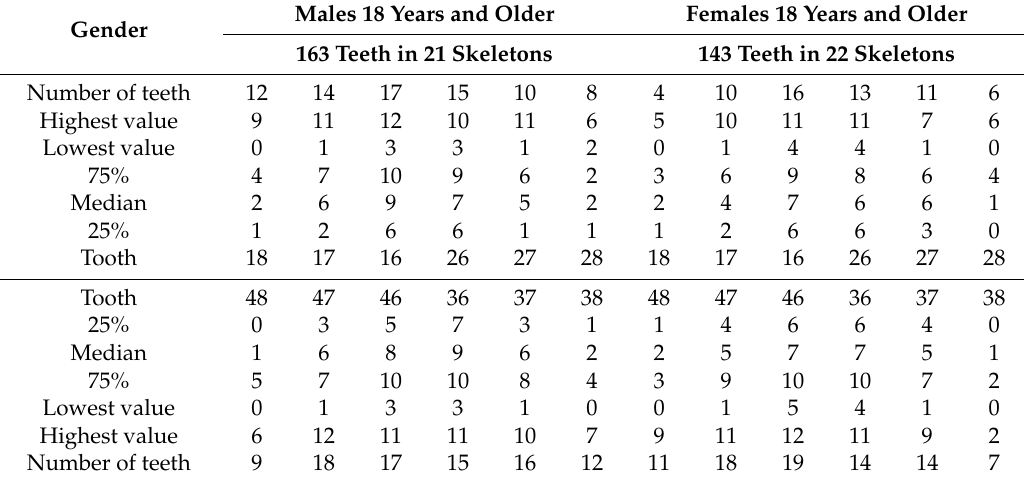
Table 5. Tooth wear for males and females according to Brothwell modification.